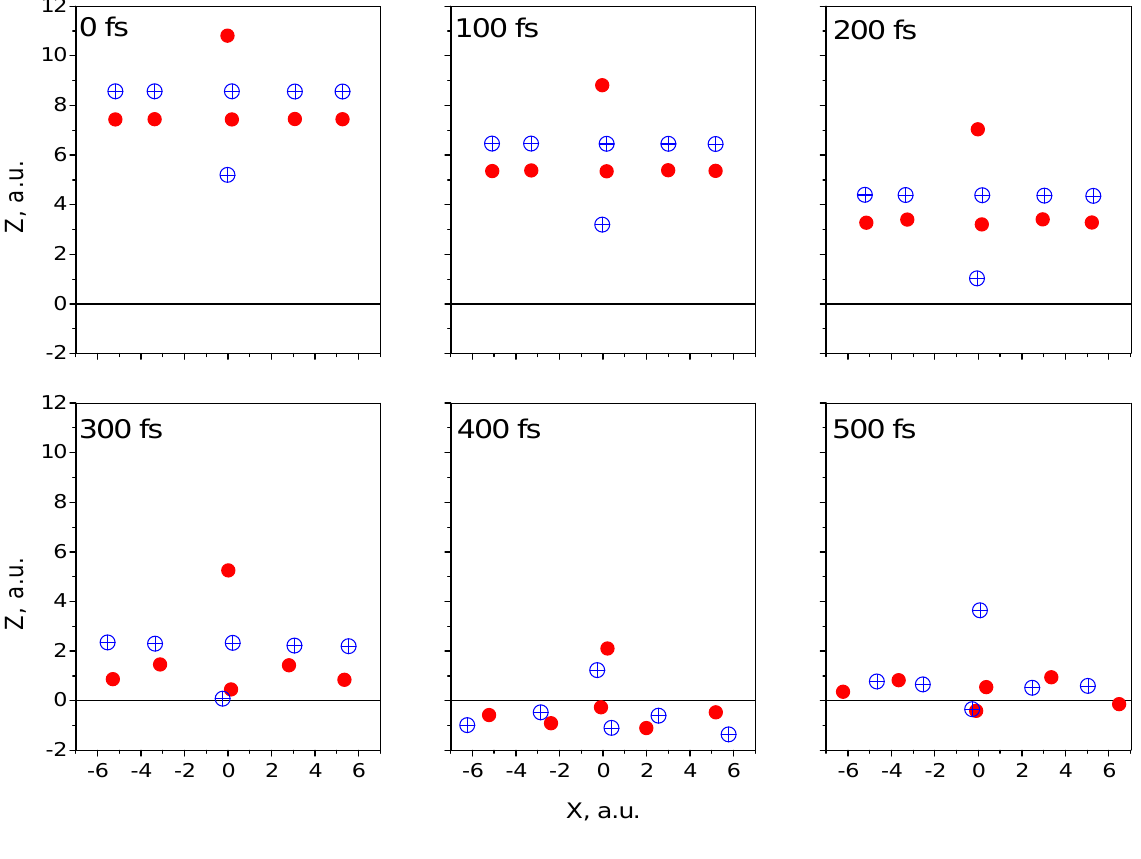
Figure 5: Time evolution of the Na cluster ions during the deposition process for an initial kinetic 6 energy 1.72 eV. Solid circles designate the ions of cluster with ”Up” orientation, and the crossed hollow circles - to the ”Down” geometry,